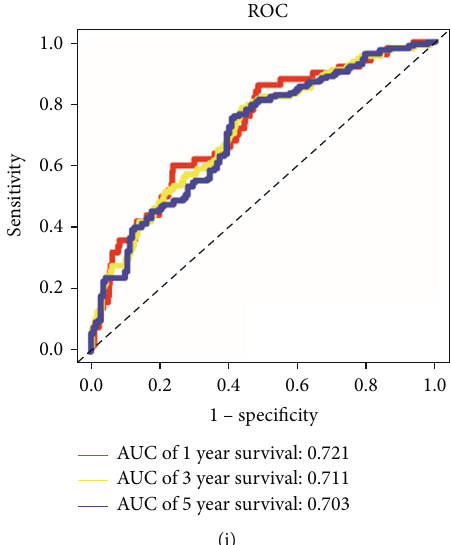
Figure 3: Prognostic analysis of necroptosis-related miRNA (NRM) signature in training, testing, and whole TCGA cohorts. (a) Risk line and risk point plots show the survival rate and risk score of each patient in the training cohort. (b) Kaplan – Meier plot of patients in the high- and low-risk groups in the training cohort. (c) ROC curve shows the prognostic performance of the NRM signature in the training cohort. (d) Risk line and risk point plots show the survival rate and risk score of each patient in the testing cohort. (e) Kaplan – Meier plot of patients in the high- and low-risk groups in the testing cohort. (f) ROC curve shows the prognostic performance of the NRM signature in the testing cohort. (g) Risk line and risk point plots show the survival rate and risk score of each patient in the entire TCGA cohort. (h) Kaplan – Meier plot of patients in the high- and low-risk groups in the entire TCGA cohort. (i) The ROC curve shows the prognostic performance of the NRM signature in the entire TCGA